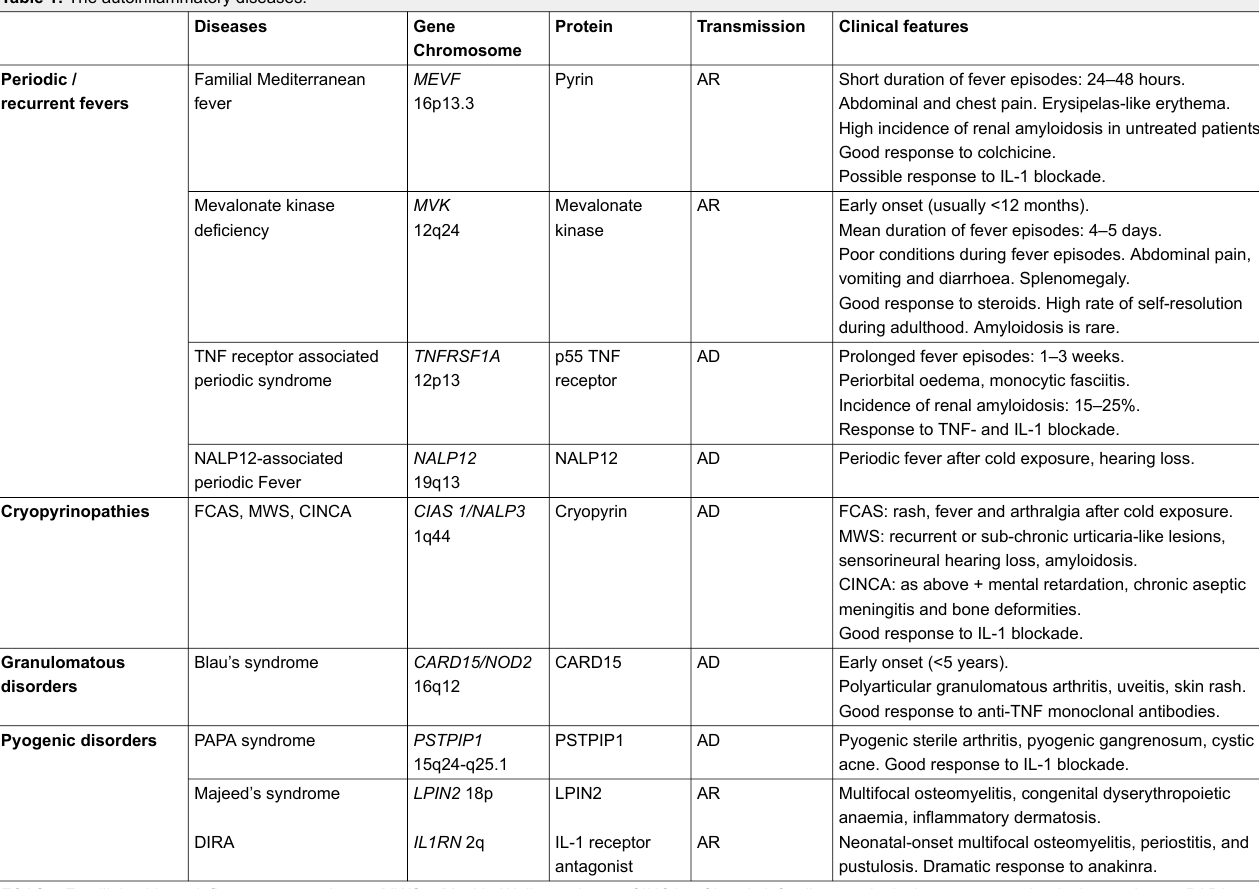
Table 1: The autoinflammatory